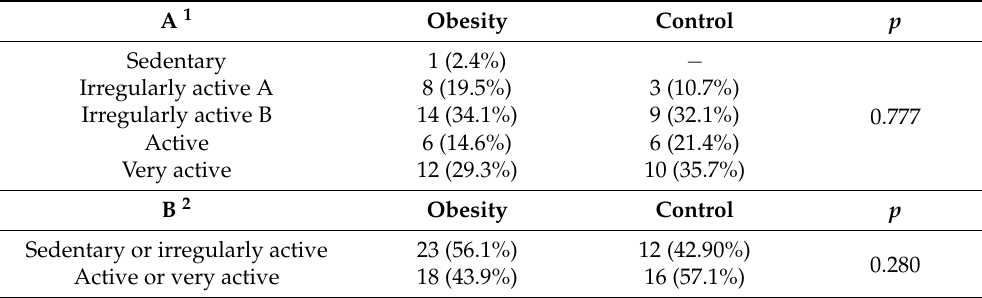
Table 2. Classification and comparison of the groups regarding the practice of physical activities, according to the IPAQ, considering the complete (A) and synthesized (B) classifications.